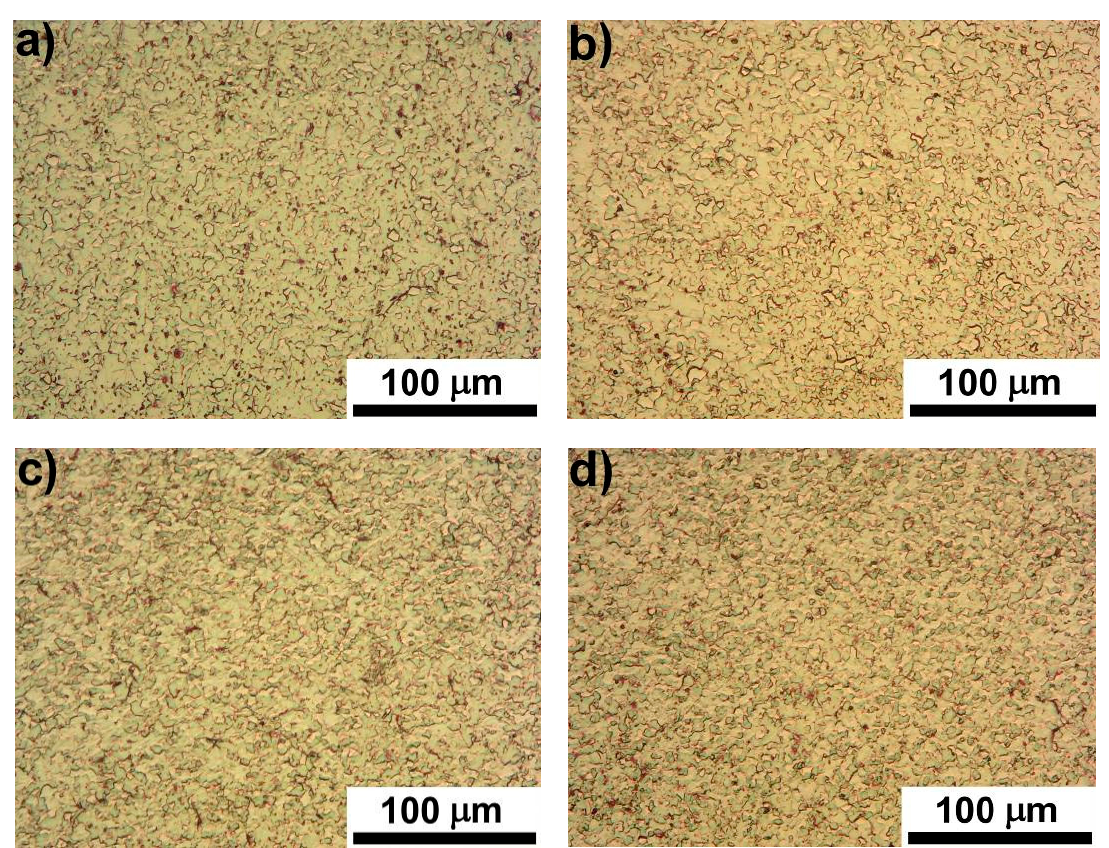
Figure 7. Microstructures of manufactured Ti Gr4 rods revealed by etching, transverse section, light microscopy: ( a ) variant V1, ( b ) variant V2, ( c ) variant V3, ( d ) variant